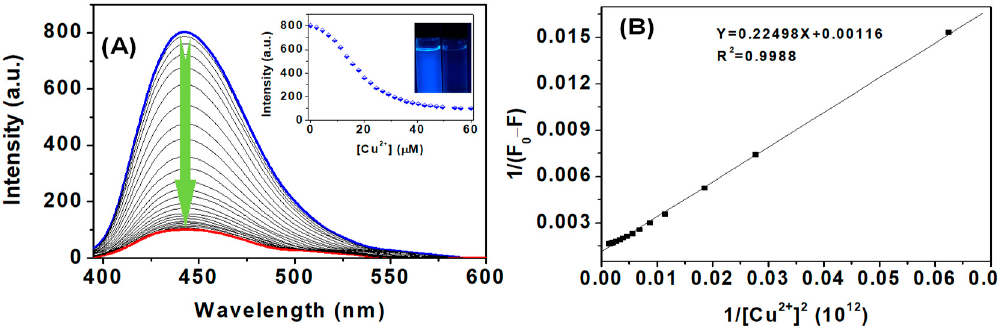
Figure 1. ( A ) Fluorescence spectra of L (10 μ M) in the presence of different amounts of Cu 2+ (0–60 μ M) in the N,N-dimethylformamide (DMF)/HEPES mixed solution (7:3, v/v, Ph = 7.4). Insert: normalized fluorescence intensities of L at 443 nm as a function of Cu 2+ concentration, and the changes of fluorescence colour in the absence and presence of Cu 2+ . ( B ) Benesi–Hildebrand linear analysis plot of L at different Cu 2+ concentration. F 0 and F represent the maximum emission of L at 443 nm in the absence and in the presence of Cu 2+ . Excitation was performed at 378 nm.